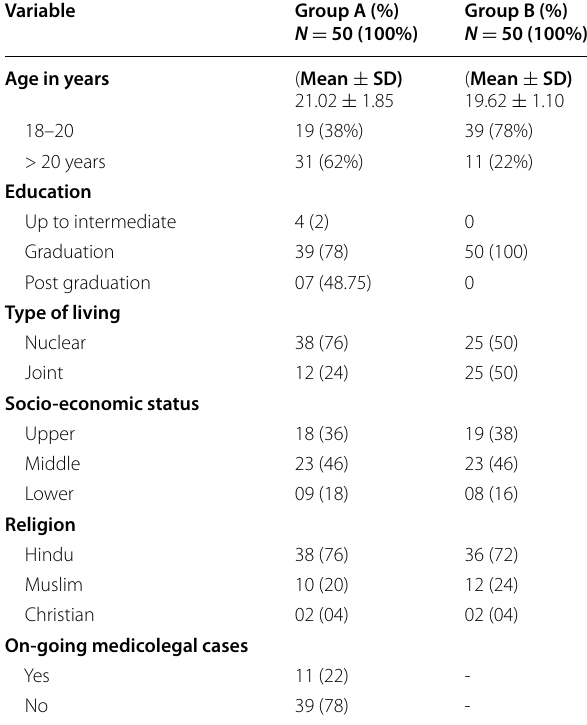
Table 1 Sociodemographic data of study